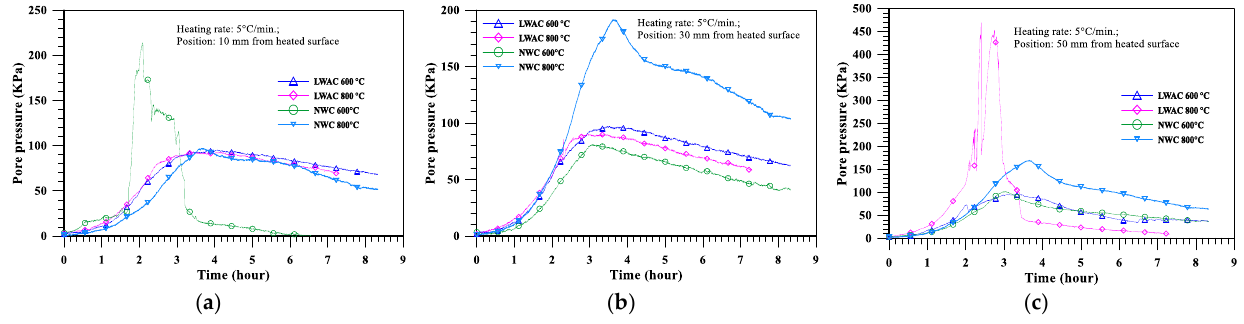
Figure 18. Effect of the target temperature on the pore pressure of air-dried specimens performed at a heating rate of 5 °C/min: ( a ) 10; ( b ) 30; ( c ) 50 mm depths.